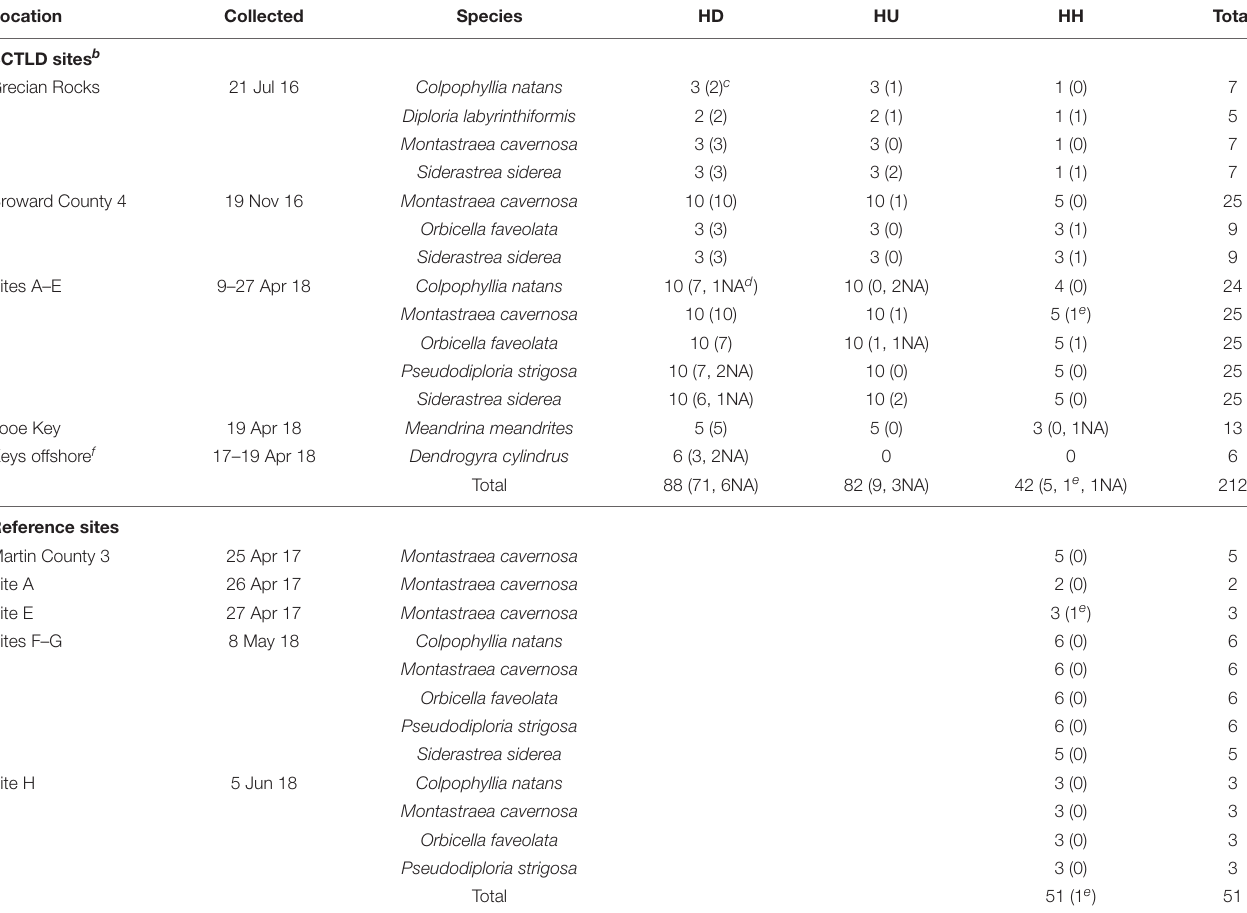
TABLE 1 | Coral species and numbers of samples a evaluated by histopathological analyses.